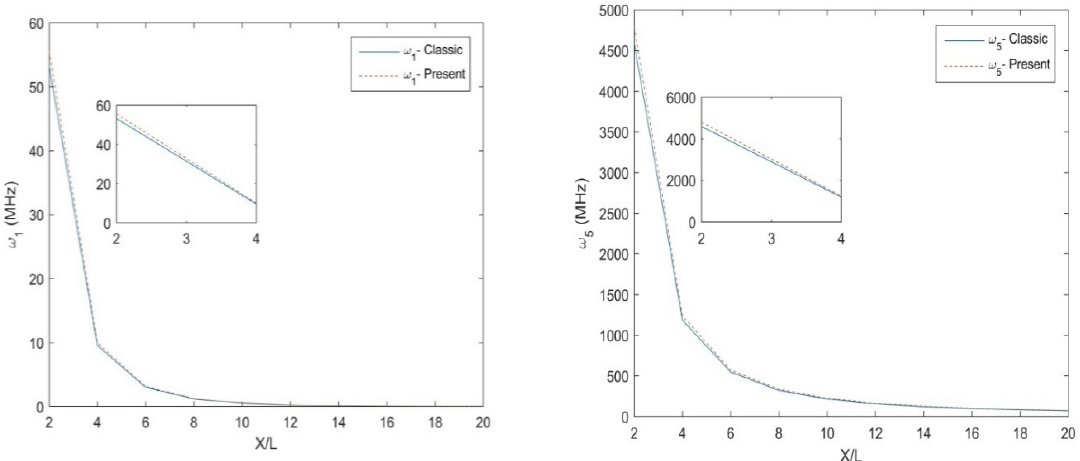
Figure 3. The 1st and 5th natural frequency of the C-F three-layer [90 ◦ ,0 ◦ ,90 ◦ ] Euler–Bernoulli non-uniform beams .